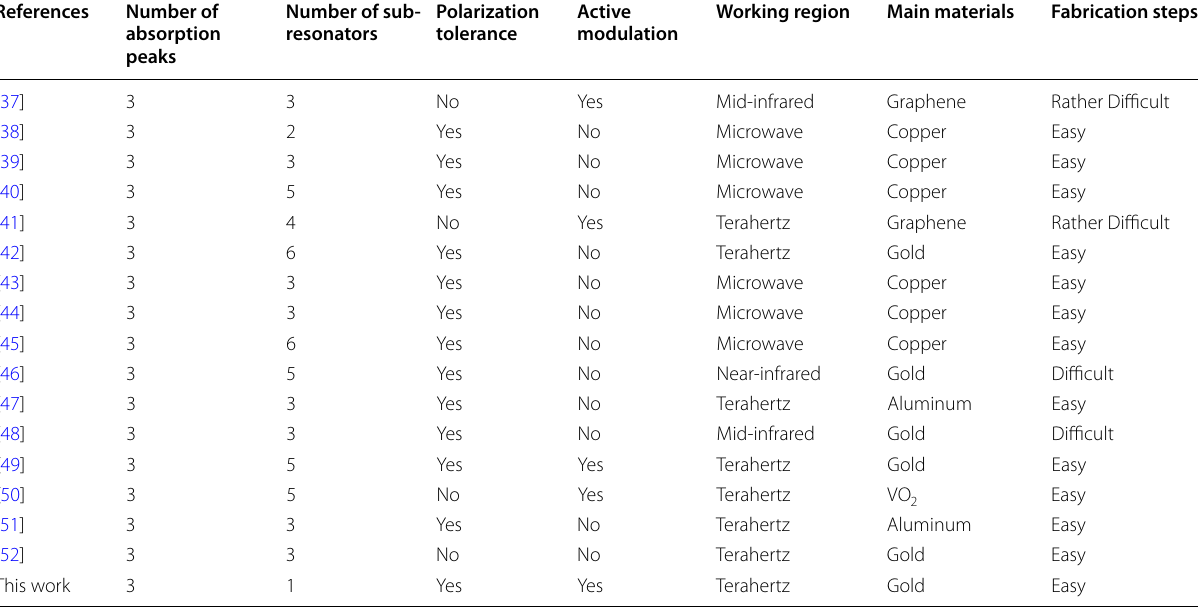
Table 1 Comparison between the designed triple‑band absorber and previously reported triple‑band metamaterial